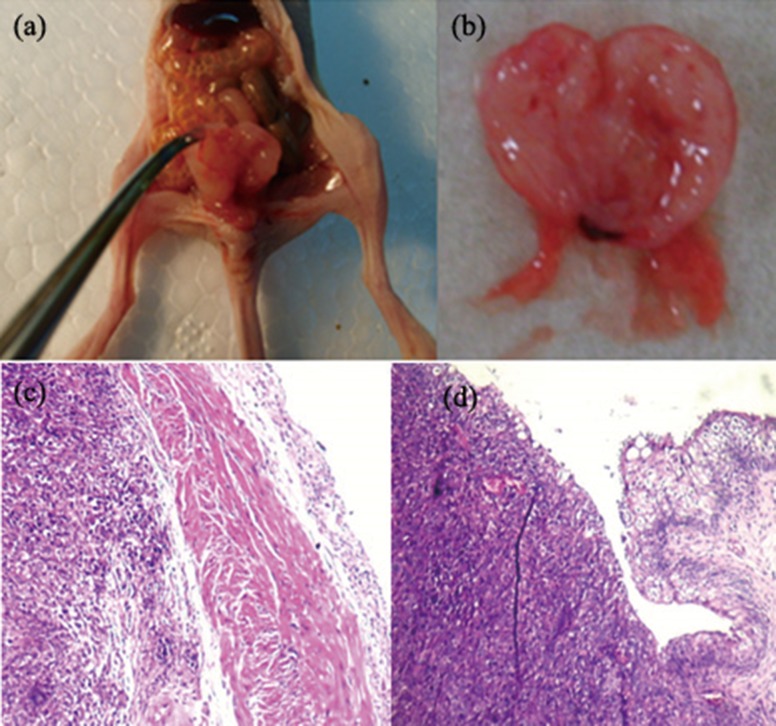
Pathological examination.(a), (b) Gross photographs show the mouse bladder was invaded by the tumor cells and enlarged. And bladder wall was diffuse thickening. (c) Pathological examination showed tumor with extensive serous membrane, muscularis propria diffuse invasion, tumor cells with loss of polarity and arranged disorder. This showed significant cytologic atypia whithout obvious necrosis. And it was solid tumor on the left side (H×200). (d) Tumor cells invading the submucosa and muscular layer on the left side. The enlarged nuclei of tumor cells showed pleomorphism with hyperchromatic, irregular nuclei, inconsistency of shape and size, irregular clumped chromatin with uneven distribution, increased ratio of nucleus to cytoplasm, and prominent enlarged nucleoli. And it was normal mucosa on the right side (H×400).